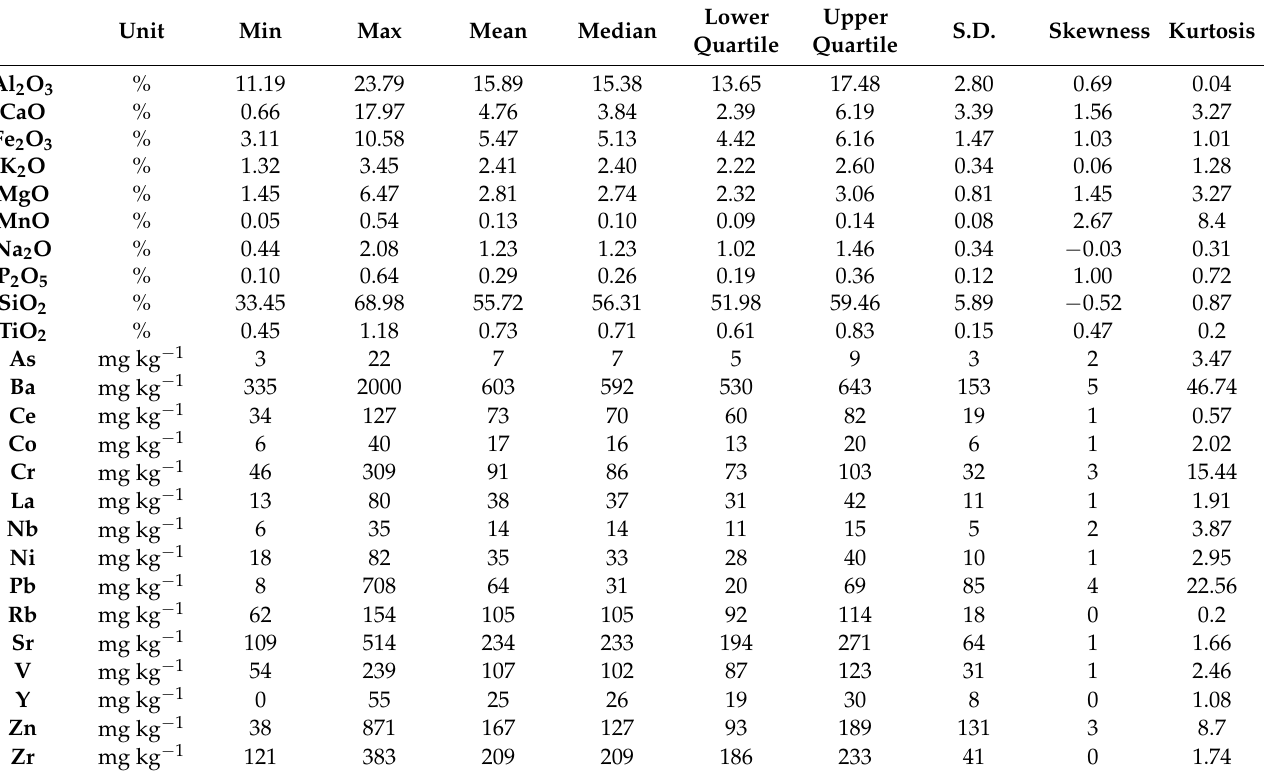
Table 1. Basic statistics for soil